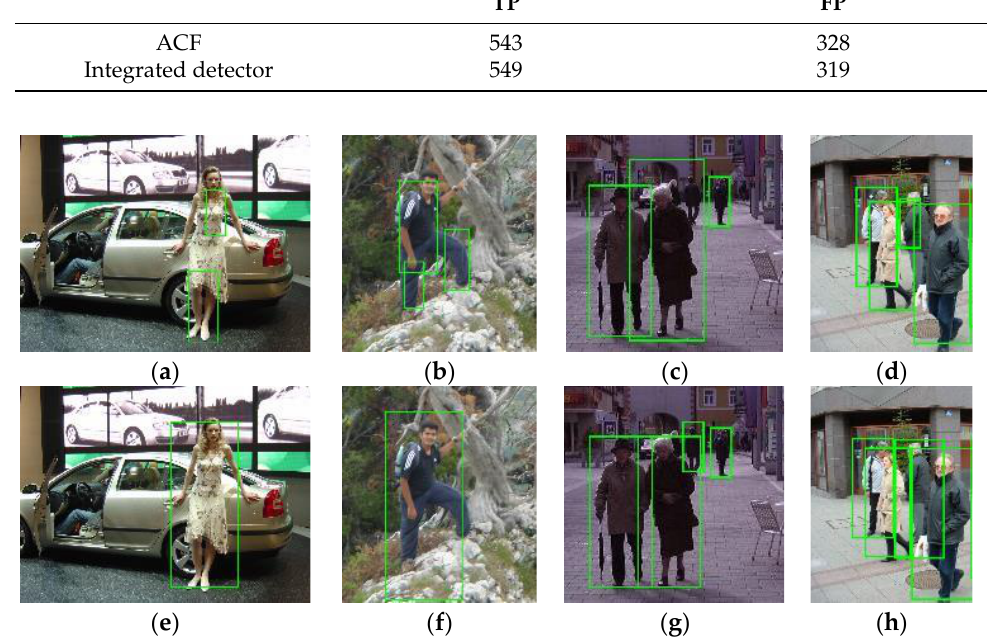
Figure 21. The integrated detector recognizes some human bodies ( e – h ) that are missed by the ACF detector ( a – d ).